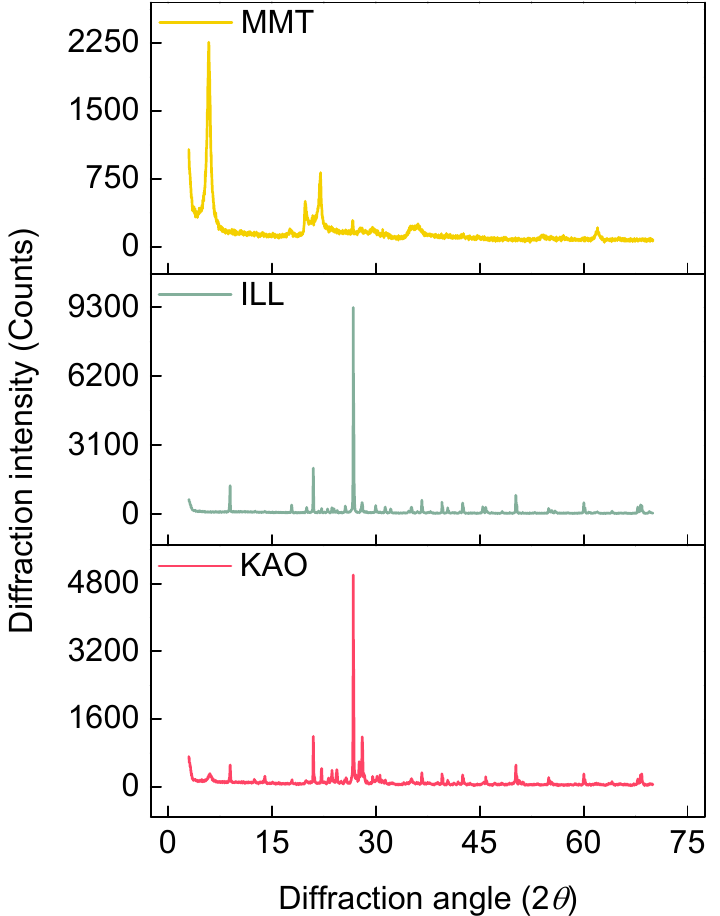
Figure 1. The X-ray diffraction topographies of the clay minerals.